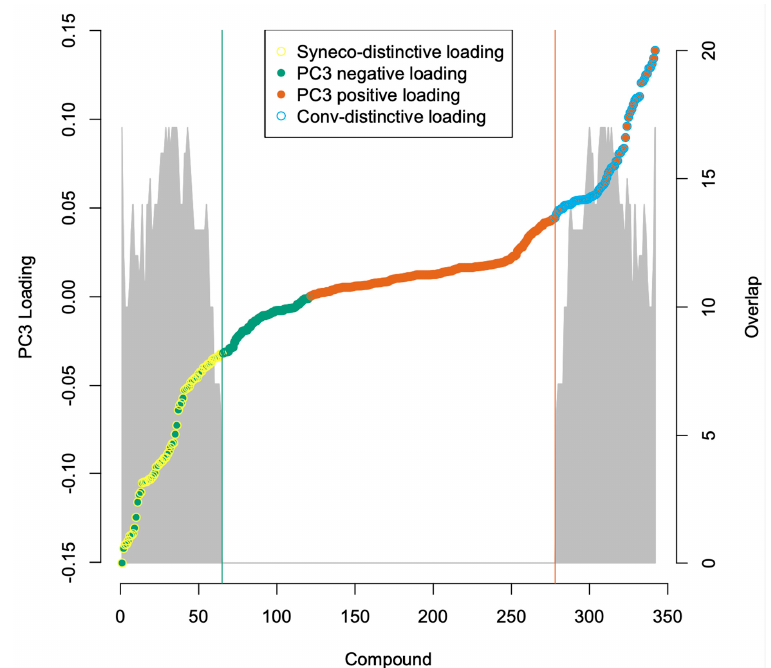
Figure 3. PC3 loading plot of the intensity of the compounds in coarse green tea samples. For negative and positive loadings of PC3 (left Y -axis) aligned in ascending order ( X -axis), the 65 smallest and 65 largest loadings of the compounds are separated by 2 vertical lines (green and orange, respectively). The top border of the grey area represents the number of overlaps of Syneco and Conv samples (right Y -axis) when LS-PCA is performed, which means the degree of inseparability between the two culture conditions. When the top 65 negative and positive loadings or more were applied to LS-PCA, the number of overlap is equal to 0, which means the Syneco and Conv samples were completely separated. Hereafter we call these 65 negative and positive loadings “Syneco-distinctive loadings” and “Conv-distinctive loadings” which are plotted with yellow and light blue hollow circles, respectively.